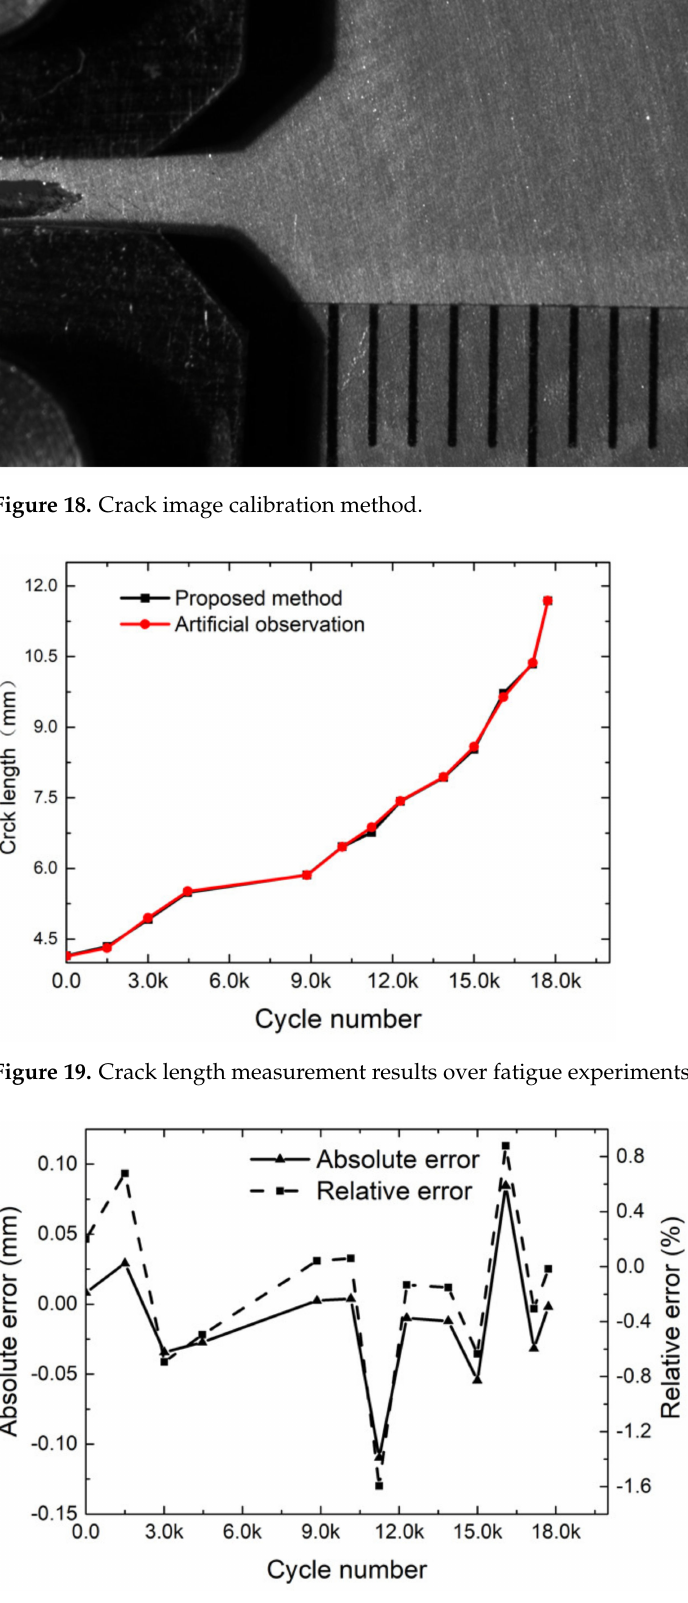
Figure 20. The absolute error and relative error of crack